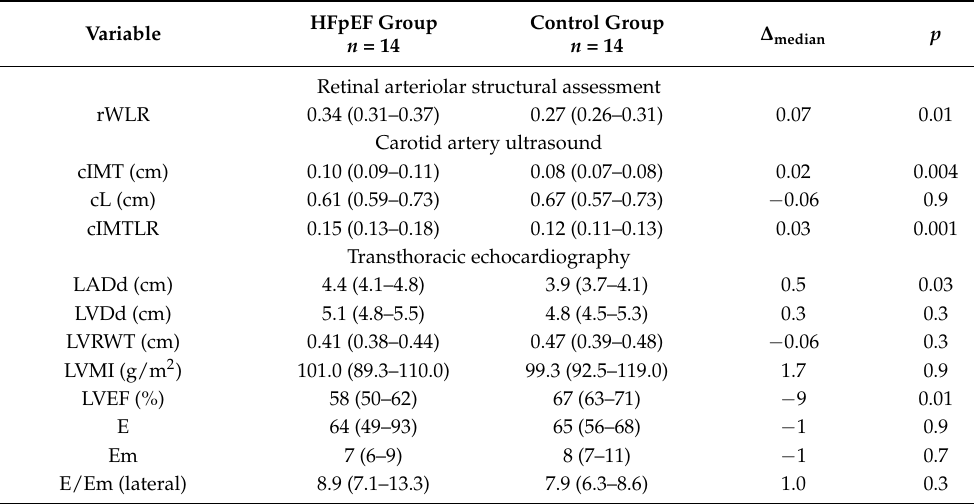
Table 3. Differences in retinal, carotid and echocardiographic markers between HFpEF and con- trol groups.